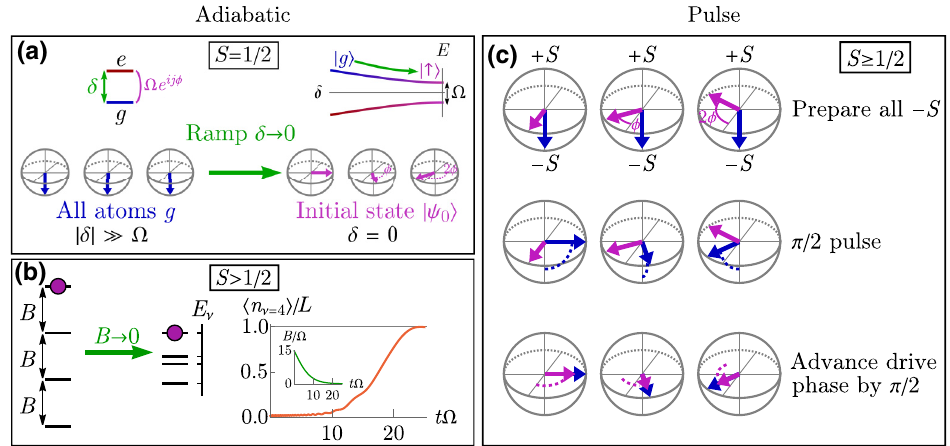
FIG. 11. (a) State preparation using a single-particle adiabatic ramp for n = 2 (spin S = 1 / 2). Atoms are initialized in the lab frame spin state g , and a laser coupling is turned on with a large negative detuning − δ (cid:15) (cid:2) . Ramping δ → 0 sweeps the system into the desired initial state | ψ 0 (cid:4) with every lattice site in the highest-energy eigenstate ↑ of the drive. (b) Similar adiabatic preparation for an n > 2 system ( S > 1 / 2). The detuning is replaced by, e.g., a magnetic field splitting of hyperfine states proportional to a field strength B , which is ramped to zero. The plot shows a numerical simulation of such a ramp for an n = 4 system, using the coupling scheme in Fig. 10(b) for sample parameters of (cid:2) + /(cid:2) 0 = 3, (cid:2)/ J = 2, and U / J = 30. The inset shows the ramp profile. The highest-energy drive eigenstate ν = 4 is prepared with > 99% fidelity. (c) State preparation protocol using a pulse and phase skip sequence, which ˆ works for a system with a S x drive and any n ≥ 2. Blue arrows denote the spin direction of each atom, while purple arrows denote the laser drive direction. Atoms are first prepared in a single lab frame spin state m = − S without any detuning or field splitting. The laser drive is turned on and used to implement a π/ 2 pulse, rotating the spins onto the equator of the Bloch sphere (or the generalized Bloch sphere of the fully symmetric manifold for n > 2). The drive phase is then skipped ahead by π/ 2 with, e.g., a fast detuning pulse, which advances its axis of rotation to be aligned with the spin state. This prepares the desired | ψ 0 (cid:4)